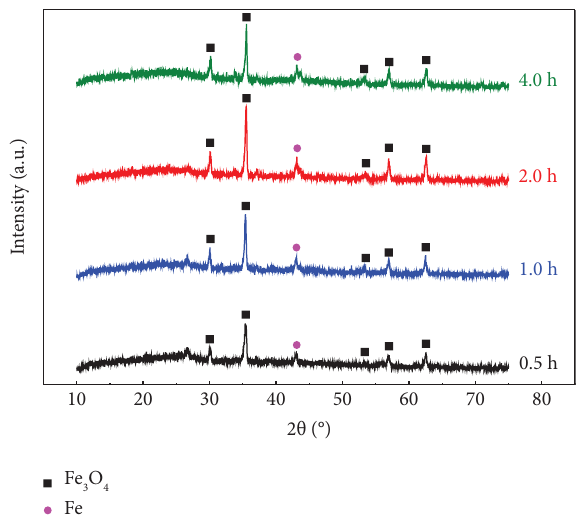
Figure 3: XRD patterns of MPC-R0.2-yh samples prepared from diferent pyrolysis time ( y